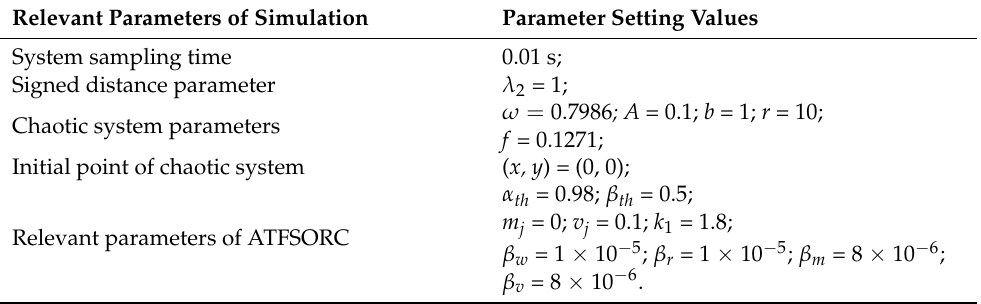
Table 3. Parameters of chaotic system stability simulation.